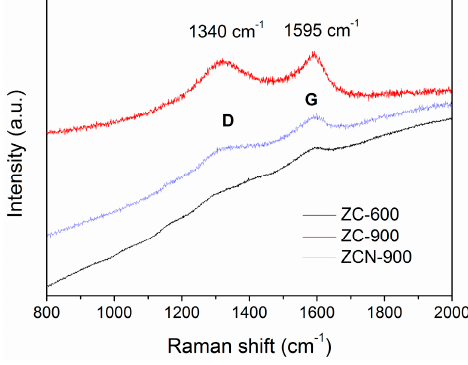
Figure 3. Raman spectra of ZC-900, ZC-900, and ZCN-900.